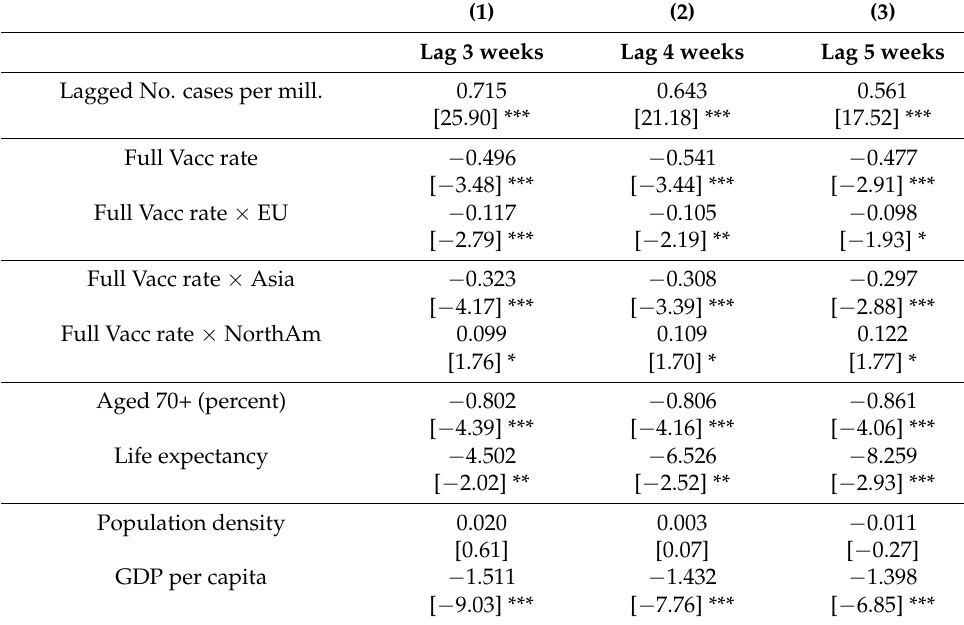
Table A4. Impact of vaccination rate on number of new hospitalized